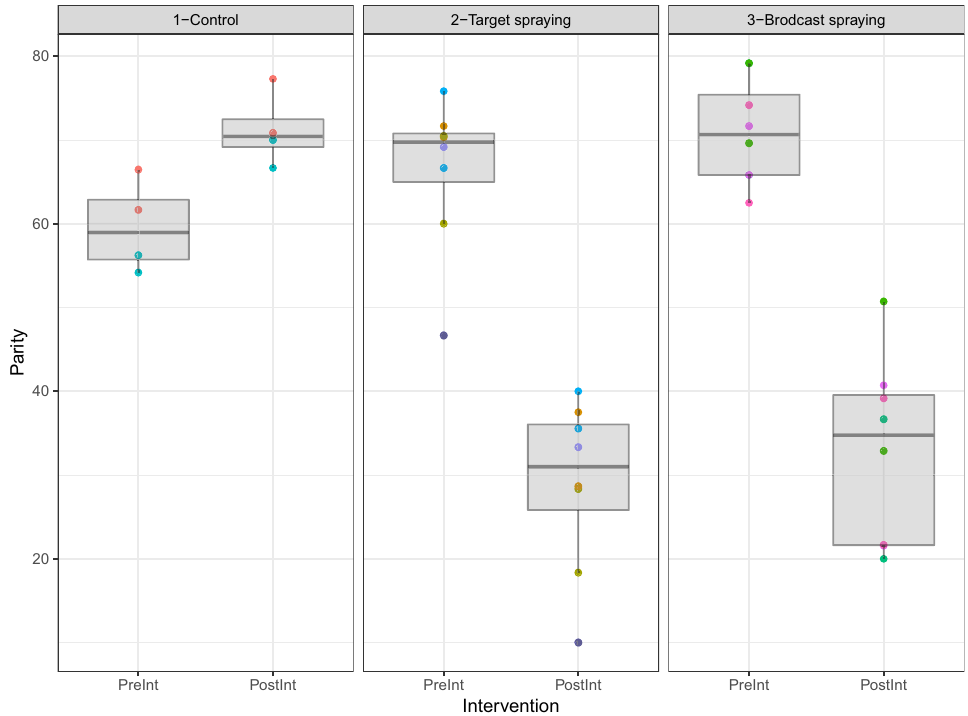
Figures 6. Plot of the parity rate. Each village is represented as a colored point and a boxplot is added to visually represent the dispersion of the data around its mean, shown pre- and post-intervention. We found highly significant effects from targeted and broadcast spraying in decreasing parity rate (p-value < 0.001).